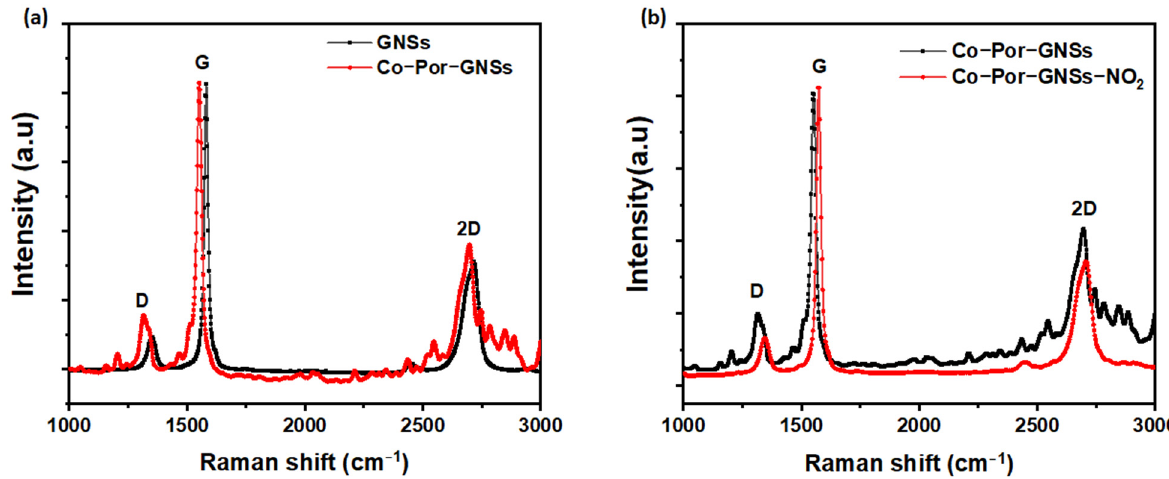
Figure 9. Raman spectra of GNSs and Co-Por-GNSs before ( a ) and after ( b ) detection of NO 2 ( λ exc = 532 nm).